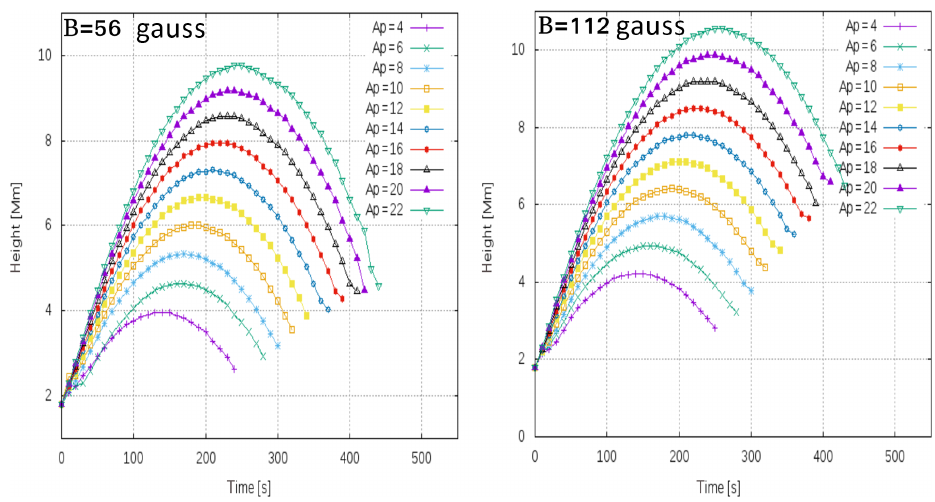
Figure 8. Height of the jets and their evolution with respect to time.